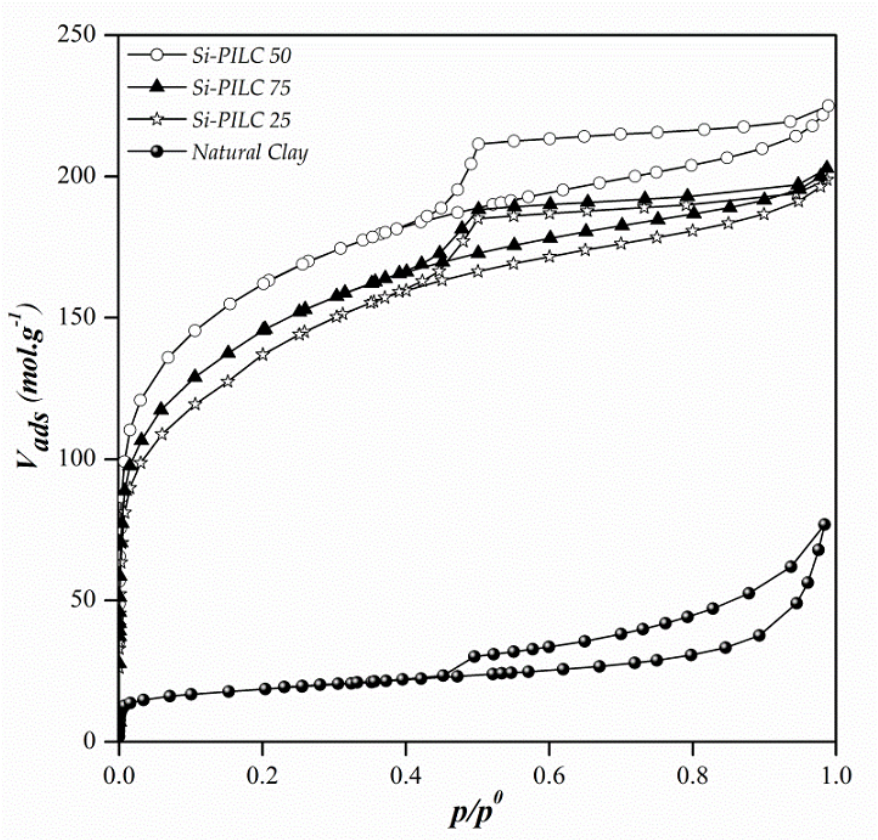
Figure 3. N 2 adsorption–desorption isotherms for the four materials.